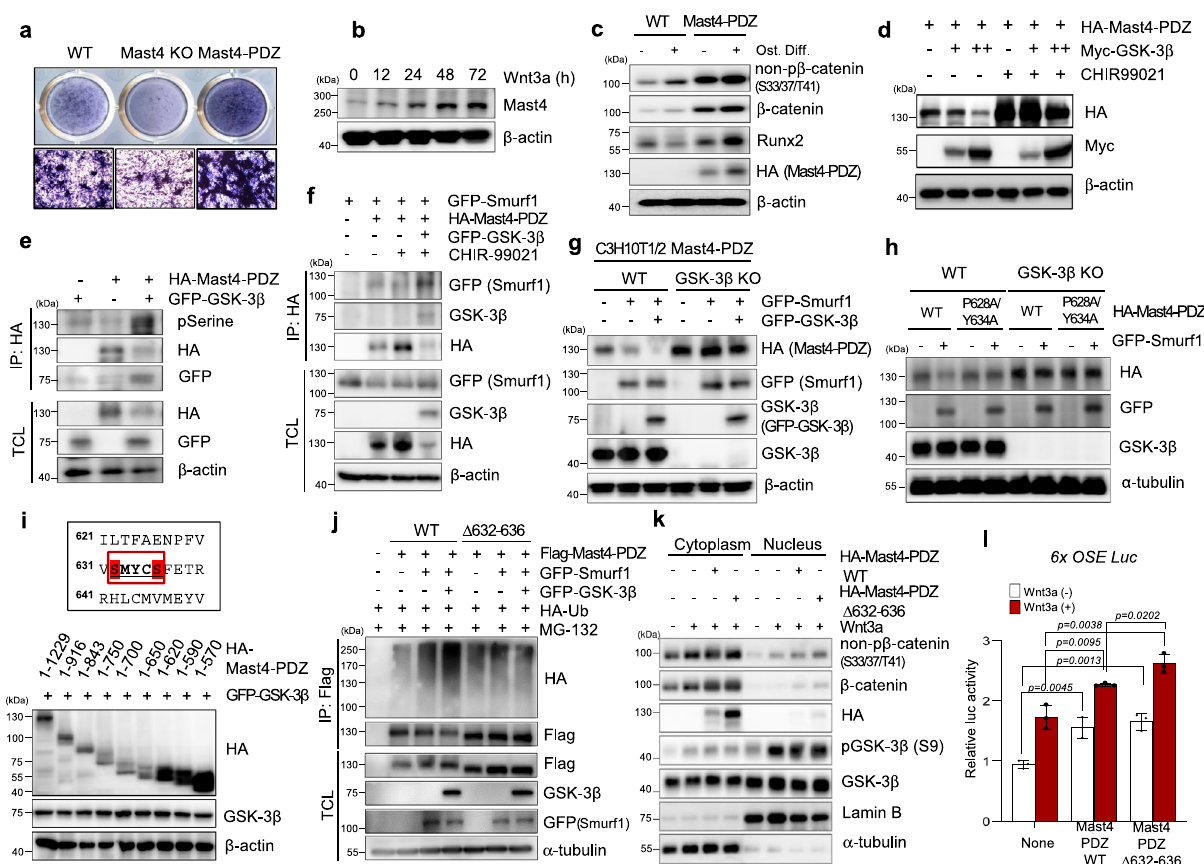
Fig. 4 Wnt induces osteogenesis by enhancing Mast4 stability through inhibition of GSK-3 β . a Representative ALP staining results of osteogenic differentiated C3H10T1/2 cells obtained from at least three independent experiments. b MC3T3-E1 preosteoblasts were treated with Wnt3a conditioned medium for the indicated time. c Wild-type and Mast4-PDZ-overexpressing C3H10T1/2 cells were differentiated into osteoblasts for 10 days. d Mast4- PDZ and GSK-3 β were transfected to C3H10T1/2 cells, followed by CHIR-99021 treatment (10 μ M for 9 h). e Mast4-PDZ and GSK-3 β were transfected to C3H10T1/2 cells, followed by immunoprecipitation assay. The bands, which were recognized by phosphoserine antibody, were later reprobed with HA antibody. f Smurf1, Mast4-PDZ and GSK-3 β were transfected to C3H10T/12 cells treated with CHIR-99021 treatment (10 μ M for 9 h), followed by immunoprecipitation assay. g Smurf1 and GSK-3 β were transfected to wild-type and GSK-3 β -depleted Mast4-PDZ-overexpressing C3H10T1/2 cells. h Mast4-PDZ WT, P628A/Y634A and Smurf1 were transfected to wild-type and GSK-3 β -depleted C3H10T1/2 cells. i Various Mast4 kinase domain deletion mutants and GSK-3 β were transfected to C3H10T1/2 cells. j Flag-Mast4-PDZ WT and Δ 632-636 were co-transfected into C3H10T1/2 cells together with HA-Ubiquitin in the absence or presence of Smurf1 and GSK-3 β . Cell lysates were immunoprecipitated with Flag antibody and immunoblotted with the indicated antibodies. k MC3T3-E1 cells were transfected with Mast4-PDZ WT and Δ 632-636, followed by treatment of Wnt3a conditioned medium (2.5 h). l 6xOSE-Luc, Mast4-PDZ WT and Δ 632-636 were transfected to C3H10T1/2 cells, followed by treatment of Wnt3a conditioned medium (18 h). Data are representative mean ± SD of three independent experiments, each conducted in triplicate ( n = 3). Unpaired two-tailed Student ’ s t test ( P < 0.05) with Benjamini-Hochberg correction for multiple tests was conducted for all statistical analyses. b – k The representative results were obtained from at least three independent experiments. TCL: total cell lysates. Uncropped blots in b – k are shown in Source Data fi le. Source data for l are provided as a Source Data fi